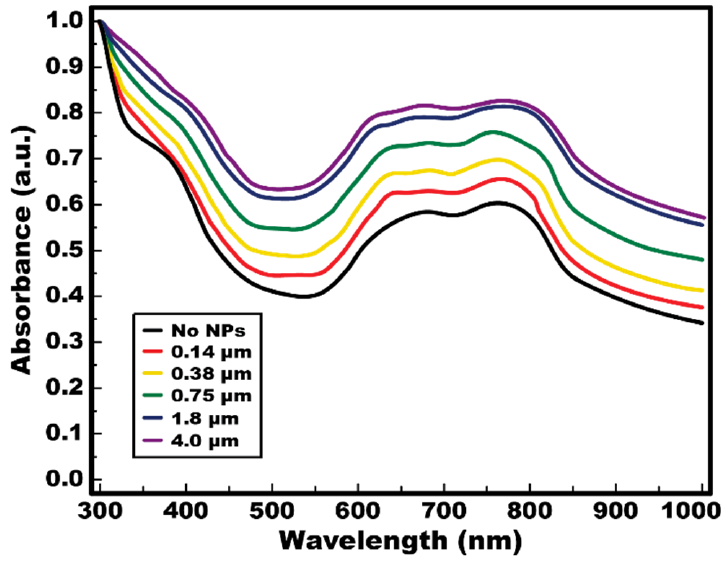
Figure 5. Spectrophotometric absorbance measurement of a TiOPc layer. The absorption spectra of an 8.0- µ m TiOPc layer were measured to study the influence of various thicknesses of the nanoparticle layer on light absorption of the TiOPc layer. The nanoparticle layers were prepared from 0.14 µ m to 4.0 µ m by simply adjusting a spin-coating speed. From the measurements, light absorption is observed to be much larger with the presence of a nanoparticle layer as compared to a pure TiOPc layer (no NPs). Notably, light absorption is further enhanced with a thicker nanoparticle layer. However, the absorption spectra of TiOPc with 1.8- µ m and 4.0- µ m-thick nanoparticle layers are very close to each other, implying saturated scattering performance of a nanoparticle layer as increasing its